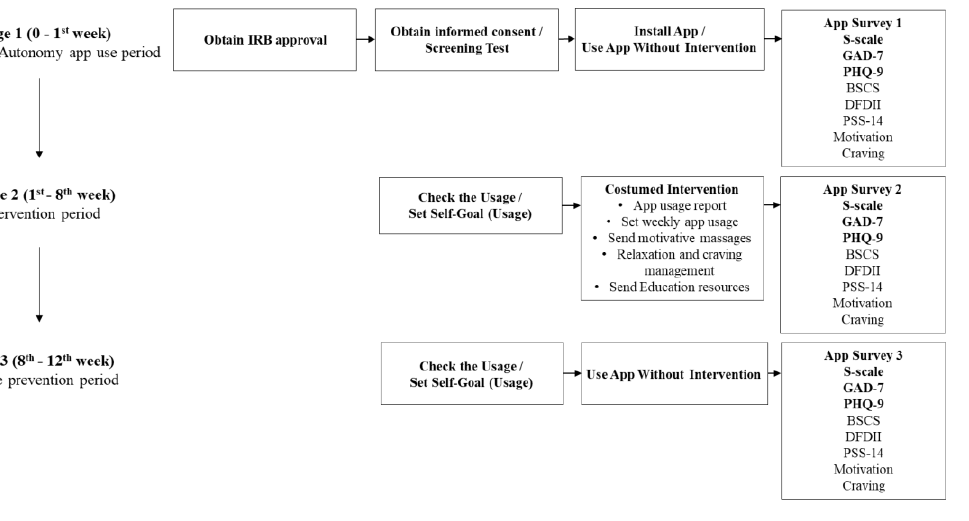
Figure 1. Study design.